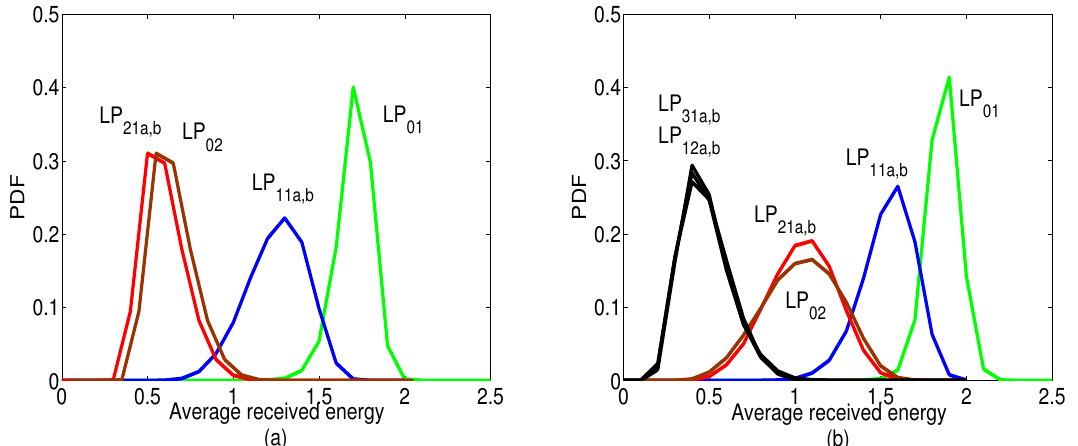
Figure 3. Probability distribution function (PDF) of the average received energy per mode. ( a ) 6-mode fiber; ( b ) 10-mode fiber.